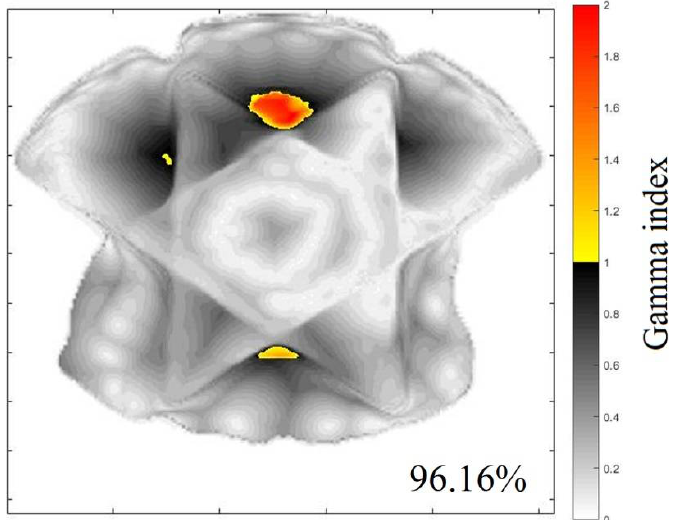
Figure 5. Gamma map index comparing the measured image and calculated image of Figure 8, with 95.57% of approved pixels (z = 6.3 cm) 20% of threshold.